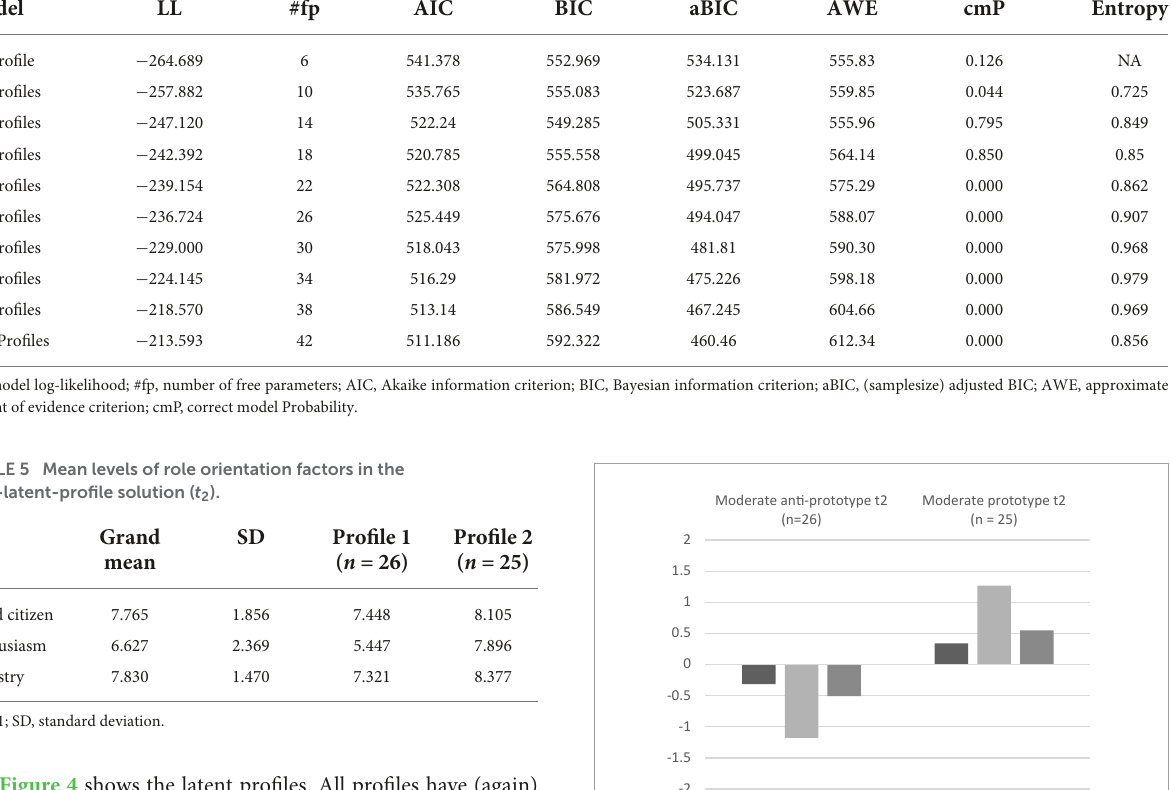
FIGURE4 Profiles of the two-latent-profile solution ( t 2 ). Zero line is the grand mean.